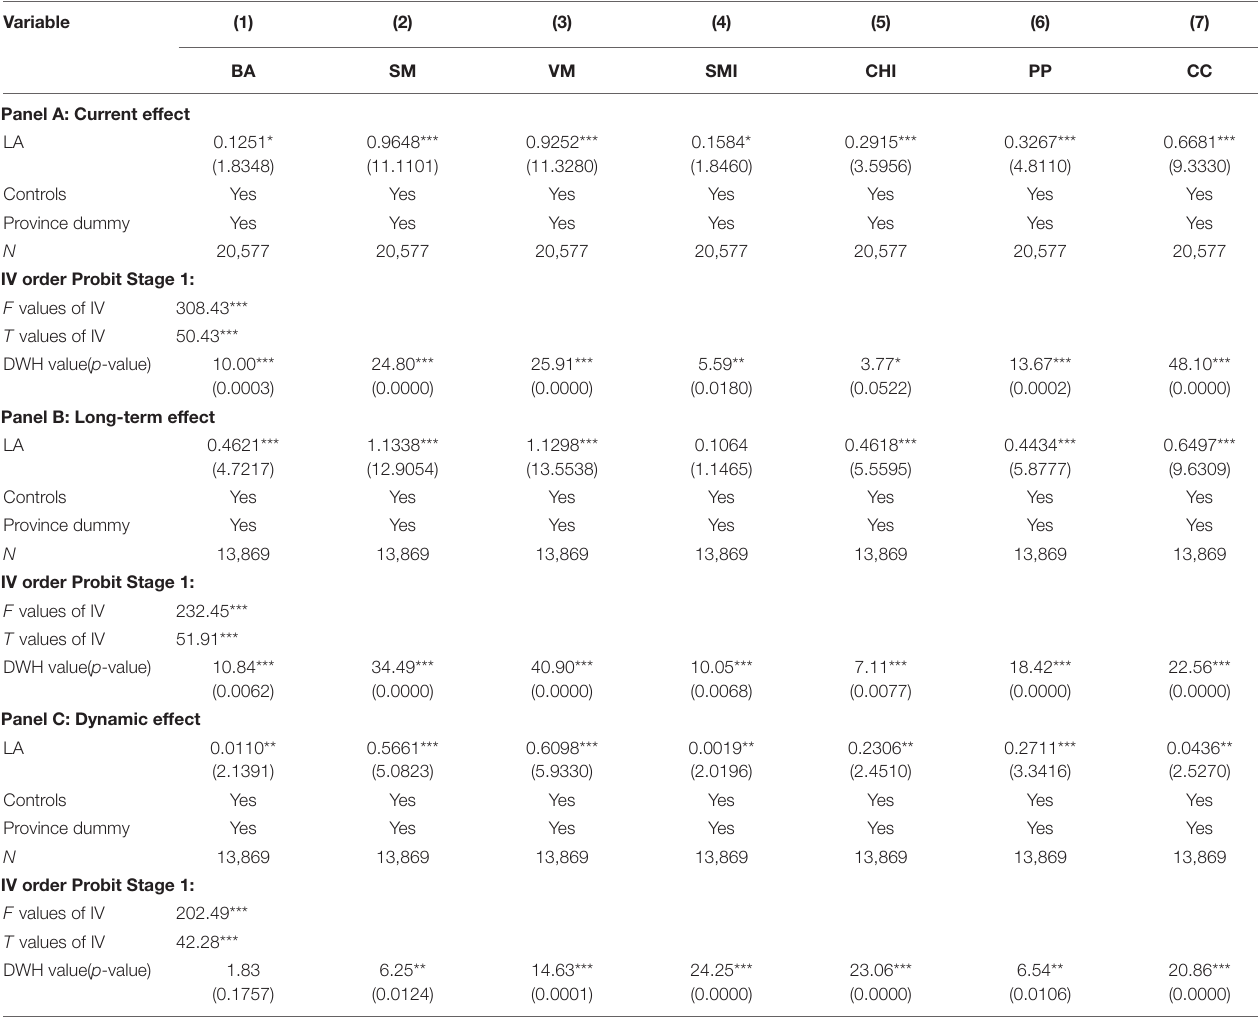
TABLE 7 | IV estimation of limited attention on financial